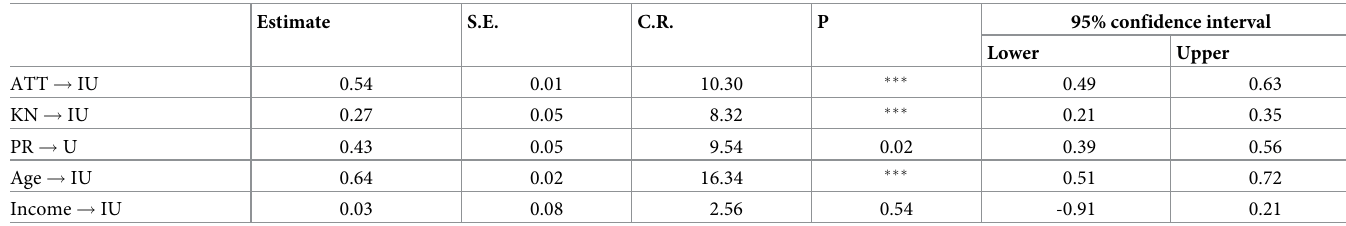
Table 3. Multiple linear regression result with estimates of intention to receive vaccine against COVID-19 among health professionals at selected hospitals in south-west, Ethiopia,